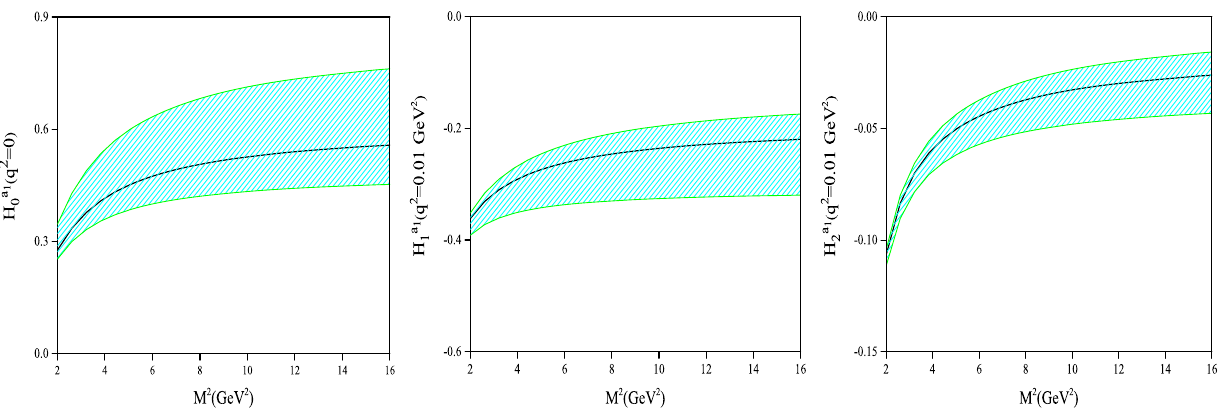
the results are plotted at q 2 = 0 . 01 GeV 2 . 1 , 2